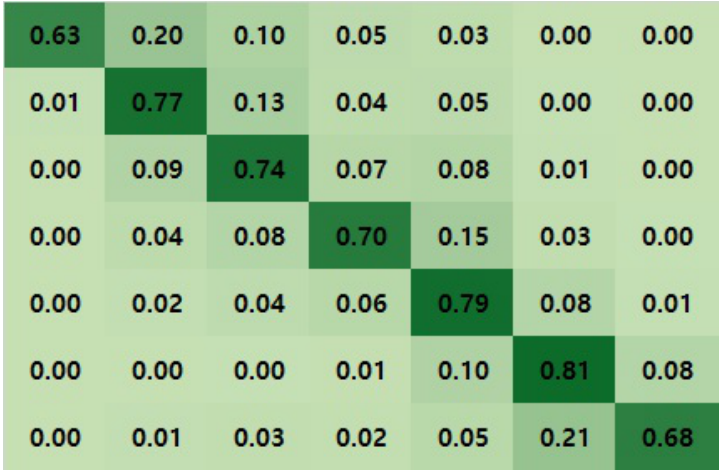
Figure 2. The confusion matrix for Random